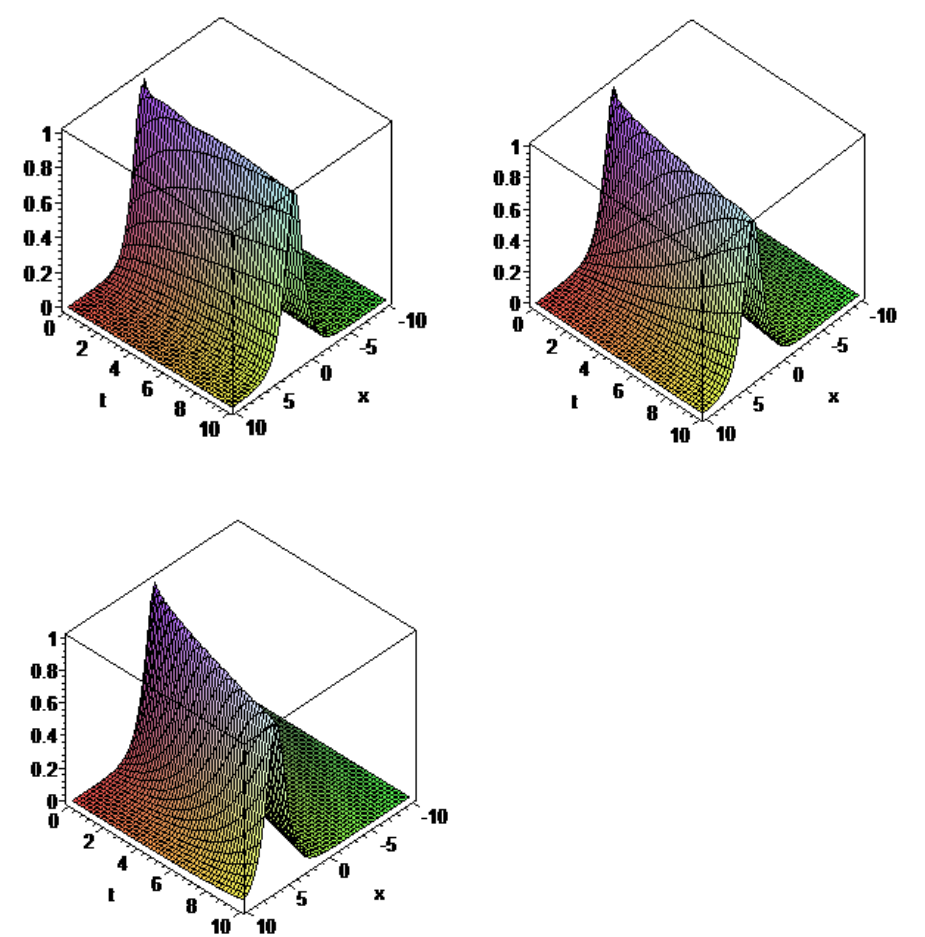
Figure 1. Graph of the solution u ( x , t ) for the values β = 0.25, 0.5 and 0.75 when a = 1, b = 1, k = c = 1.